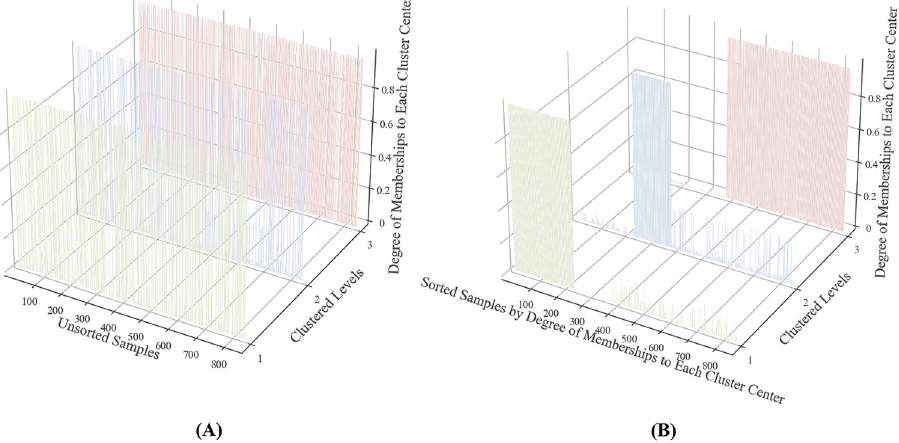
Fig 3. The degree of membership of PSSFC for each primary school clustered by FCM ( c = 3). (1) All sampled schools in the initial order and random sort. (2) Sorted by the DM for each school belong to every